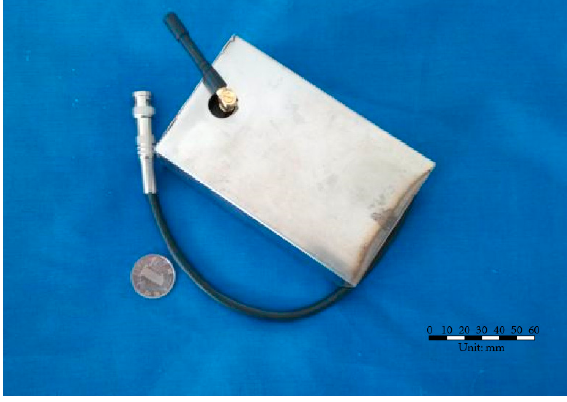
Figure 3. A Health monitoring node used in the experiment.